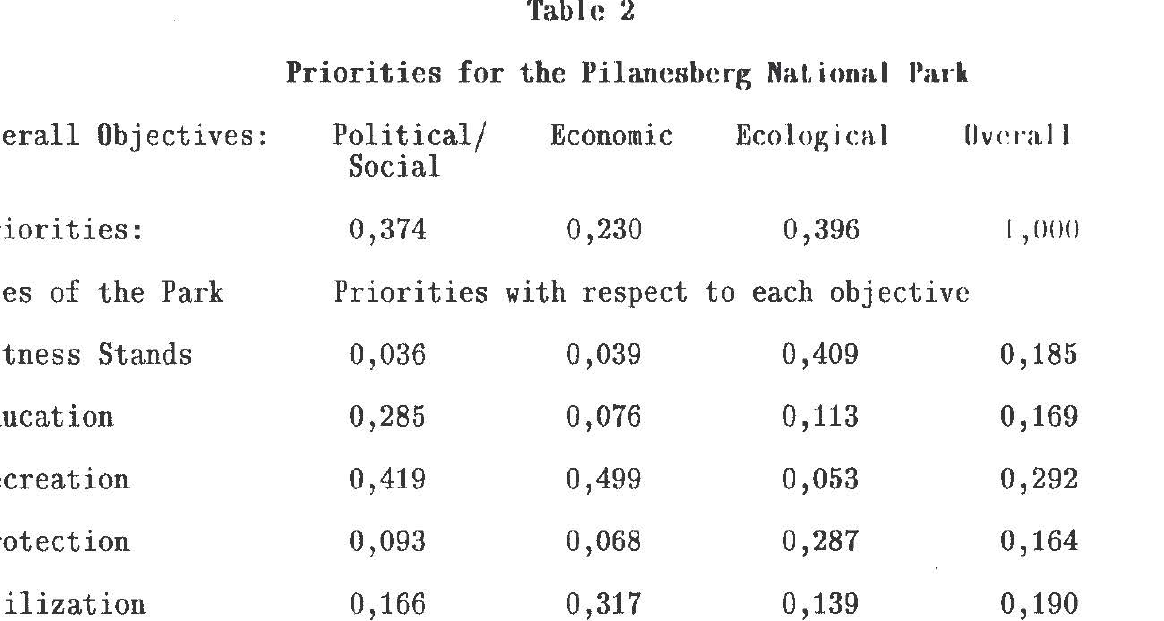
Priorities for the Pilancsbcrg Nat. ionu.l